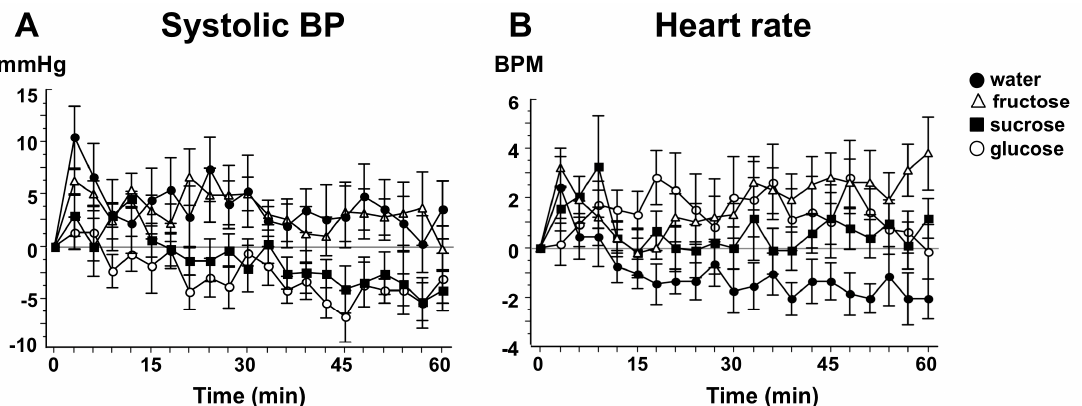
Figure 3. Change from baseline in ( A ) Systolic blood pressure (BP) and ( B ) Heart rate in 10 healthy older people following ingestion of four different study drinks ( ○ , glucose; ■ , sucrose; ∆ , fructose; ● , water). Values are means ± SEM [50].